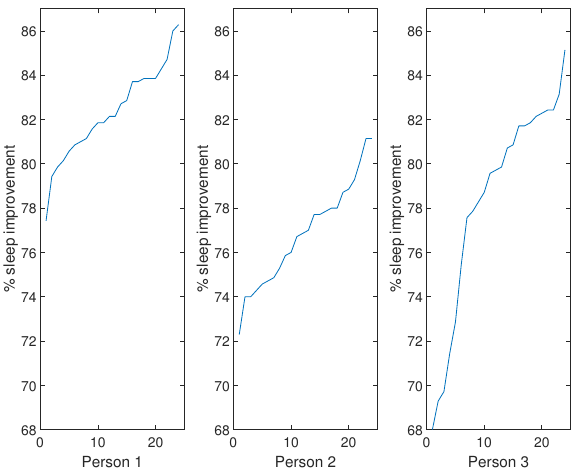
Figure 23. Distribution values for three random people in the